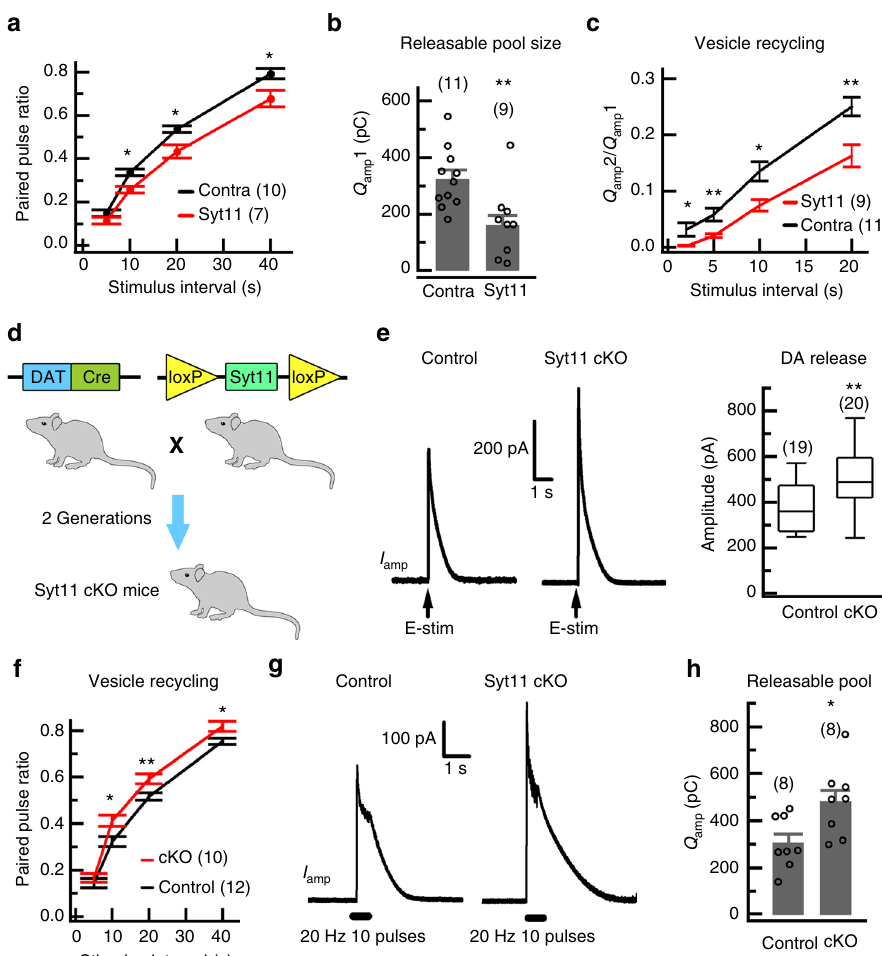
Fig. 5 Syt11 inhibits vesicle pool replenishment in dopaminergic neurons. a Paired-pulse ratios of DA release with different interstimulus intervals recorded in the striatum contralateral (Contra) or ipsilateral (Syt11) to the SNpc with Syt11-OE ( P = 0.075, 0.021, 0.016, and 0.022 for 5, 10, 20, and 40 s; n represents slices from four mice). b Statistics showing the reduced releasable vesicle pool size ( Q amp 1) by Syt11-OE revealed by the DA release in response to a burst of pulses (20 Hz, 10 pulses). P = 0.003, n represents slices from four mice. c Recovery rate of readily-releasable vesicle pools ( Q amp 2/ Q amp 1) at different interstimulus intervals. A burst of pulses (20 Hz, 10 pulses) was used to deplete the releasable vesicle pools ( Q amp 1) and the following single- pulse stimulation was used to assess the recovery of readily-releasable vesicle pools ( Q amp 2). P = 0.026, 0.007, 0.012, and 0.007 for 2, 5, 10, and 20 s; n represents slices from four mice. d Schematic of the generation of DAT-driven Syt11-cKO mice. Homozygous fl oxed Syt11-null mice were crossed with DA transporter-driven Cre heterozygous knockin (DAT-Cre) mice to produce DA neuron-restricted Syt11 conditional knockout (Syt11-cKO) mice. e Representative I amp evoked by single Estim pulse and statistics showing increased DA release in the striatum of Syt11-cKO mice ( P = 0.008, n represents slices from fi ve mice). f Paired-pulse ratios of DA release with different interstimulus intervals ( P = 0.443, 0.010, 0.006, and 0.017 for 5, 10, 20, and 40 s; n represents slices from fi ve mice). g Representative I amp evoked by burst Estim pulses in the striatum of control and Syt11-cKO mice. h Statistics showing the increased releasable vesicle pool size ( Q amp ) in the striatum in Syt11-cKO mice ( P = 0.020, n represents slices from four control and three Syt11-cKO mice). Data are shown as mean ± s.e.m. and unpaired Student ’ s t -test is used for a – c , f , h . Mann – Whitney test is used for e , box and whisker plots show medians (central line in the box), ranges between 25th and 75th percentiles (box) and minimum – maximum ranges (whiskers). * P < 0.05, ** P <